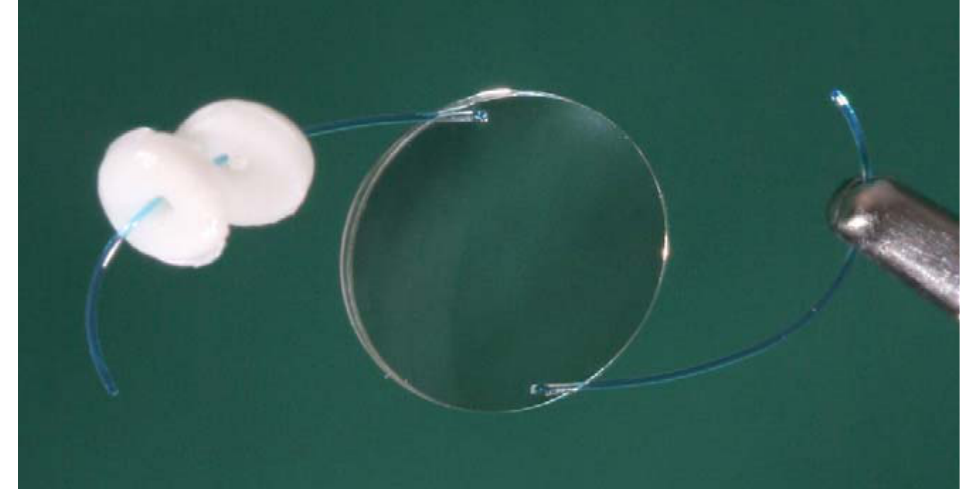
Figure 1. Picture of the intraocular lens (IOL) combined with two drug delivery systems. Reproduced from reference [27] with permission of